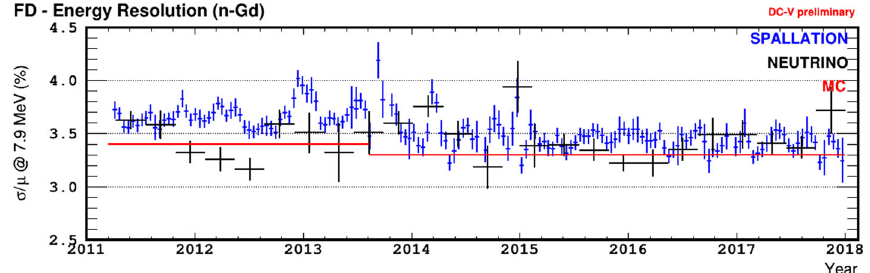
Fig. 28 Stability of energy resolution at about 8MeV (Gd-peak) in the Double Chooz far detector over the 7 years of data taking. The blue data points correspond to the capture of spallation neutrons, the black points